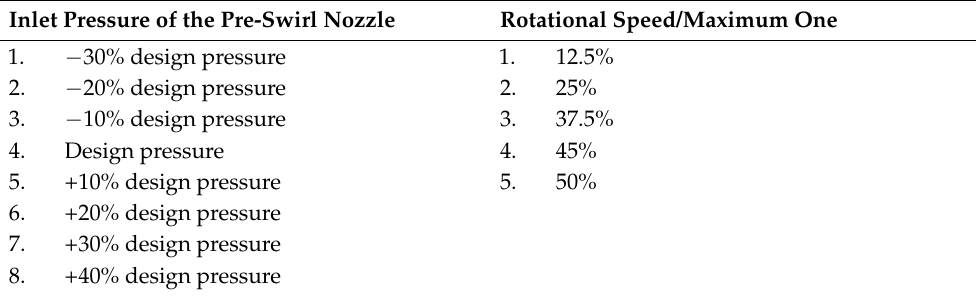
Figure 2. Domains and grids for numerical simulation. ( a ) Domains for numerical simulation; ( b ) Grids for numerical simulation. Table 2. Main parameters of different